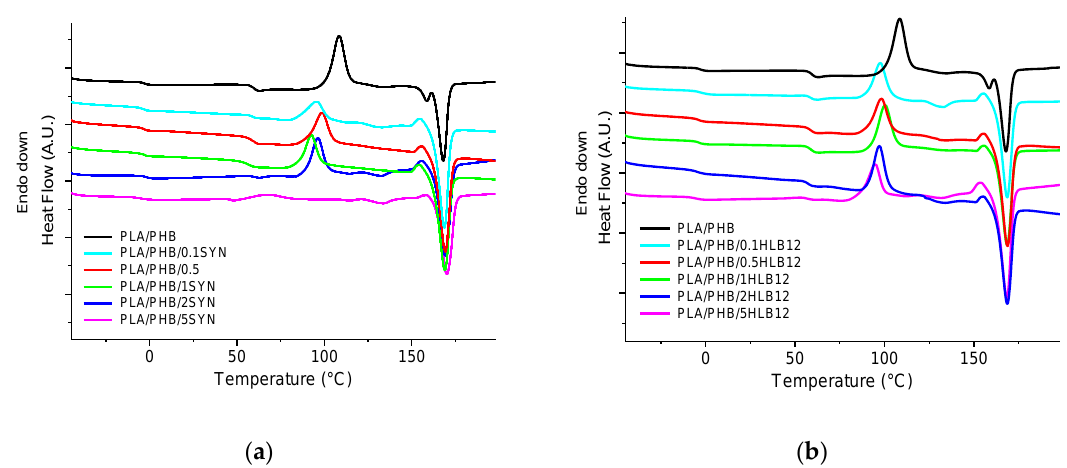
Figure 1. Differential scanning calorimetry (DSC) thermograms recorded during the second heating scan for ( a ) Syn- and ( b ) HBL12-containing systems, compared to that of the polylactic acid/poly-hydroxy butyrate (PLA/PHB) blend.